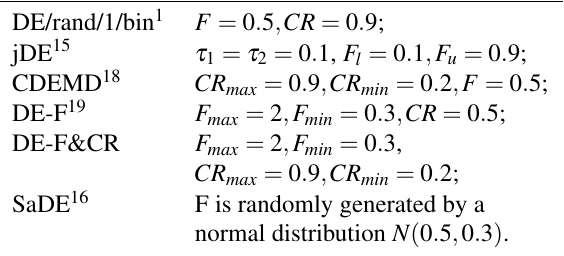
Table 2. Parameter specification for the algorithms used DE/rand/1/bin